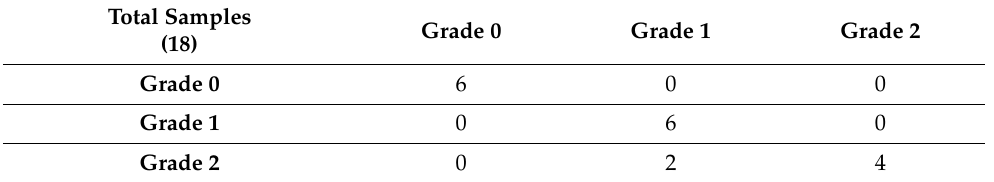
Table 5. Testing confusion matrix of RMSPROP empowered with AlexNet (non-augmented test data).